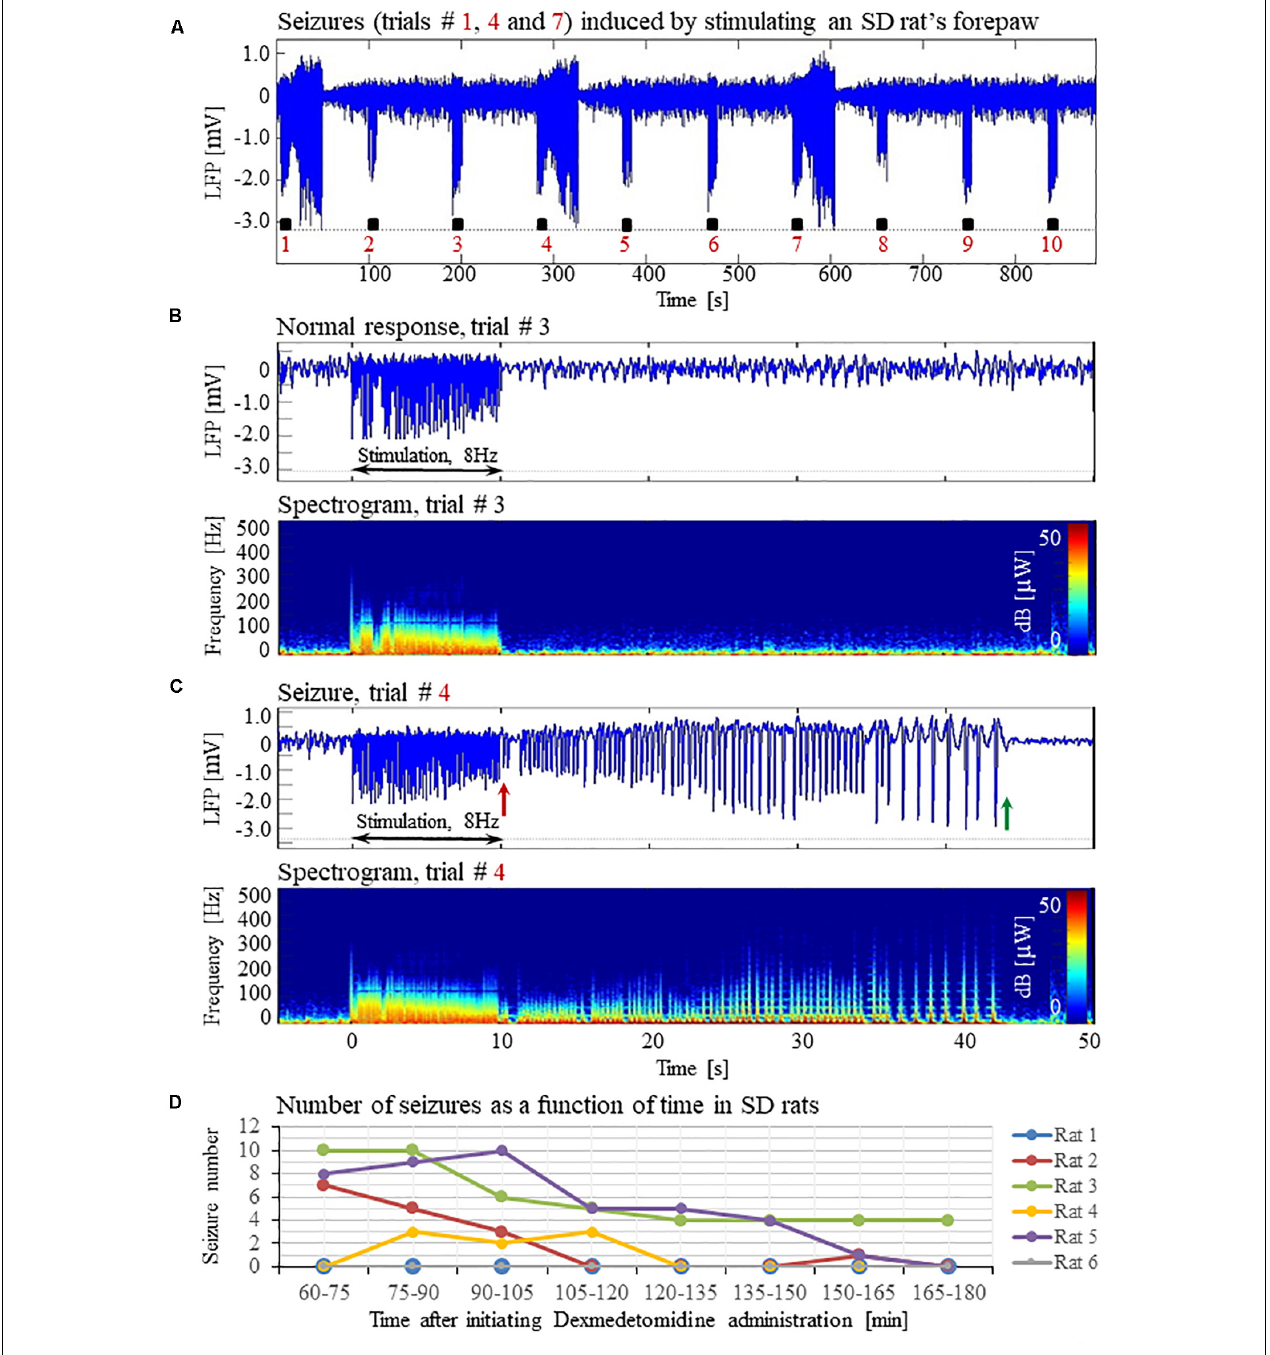
FIGURE 1 | Forepaw stimulation induces epileptic activity in rat area S1FL. (A) LFP recordings of ten trials, each with 10 s-long stimulation. The stimulation periods are marked by black rectangles. Each 10 s stimulus consisted of a train of electrical pulses delivered at 8 Hz to the forepaw. Note that during the first, fourth, and seventh trials, the stimulation evoked a seizure. (B) Top: The LFP (mean averaged over electrode contacts spanning the cortical depth) demonstrates a normal-evoked response in trial #3. Bottom: The corresponding spectrogram (power as a function of frequency and time) computed for the same trial. (C) Top: LFP (mean averaged over electrode contacts spanning the cortical depth) showing a seizure pattern in trial #4. The red and green arrows indicate the onset and termination, respectively, of a seizure induced by forepaw stimulation. Bottom: The corresponding spectrogram, computed for the same seizure. (D) The number of evoked seizures per rat as a function of time shows that seizures were induced already during the first or the second run, only one hour after initiating the dexmedetomidine administration.